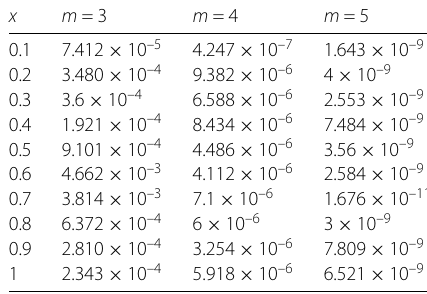
Table 2 The absolute error of u ( x , t ) for different values of